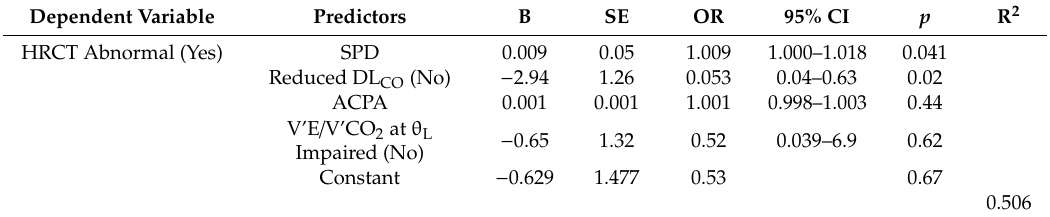
Table 4. Logistic regression model for predictors associated to the presence of HRCT